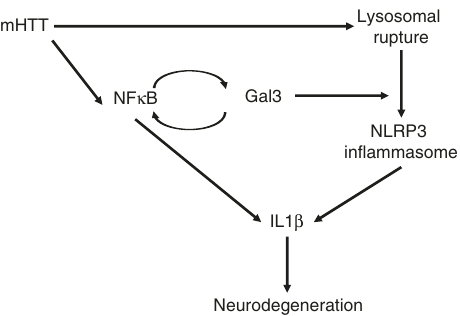
Fig. 10 Schematic representation of the detrimental role of Gal3 in HD microglia. Under normal conditions, microglia express low levels of Gal3 and pro-in fl ammatory cytokines. In Huntington ’ s disease, the presence of mHTT activates NF κ B, which evokes the expression of Gal3, NLRP3, and pro-in fl ammatory cytokines (such as IL1 β ). Gal3 further activates NF κ B through a positive feedback loop. On the other hand, the presence of mHTT triggers lysosomal damages as demonstrated by aggregation of Gal3 on the ruptured lysosomes. Furthermore, Gal3 inhibits the clearance of damaged lysosomes and promotes the assembly of NLRP3 in fl ammasomes,